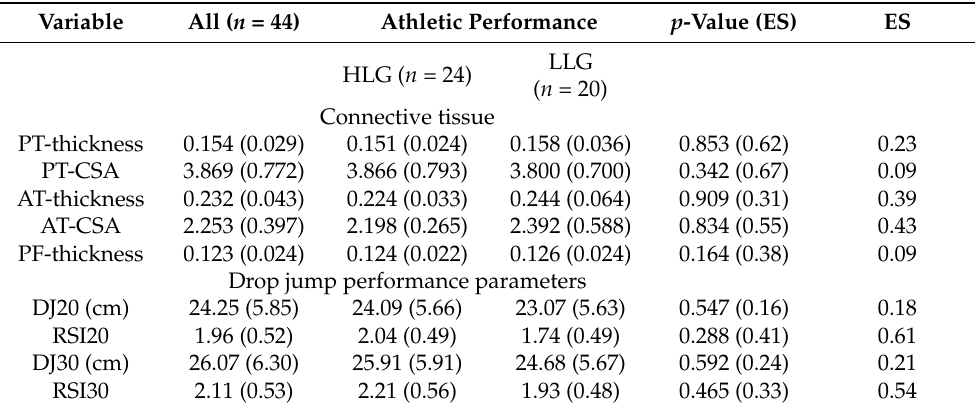
Table 3. Morphology of the normalized to body mass connective tissue and drop jump performance parameters regarding athletic performance